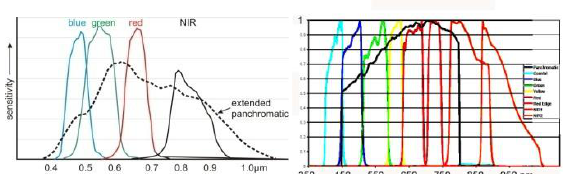
Figure 12. Spectral sensitivity of IKONOS and QuickBird left and for WorldView-2